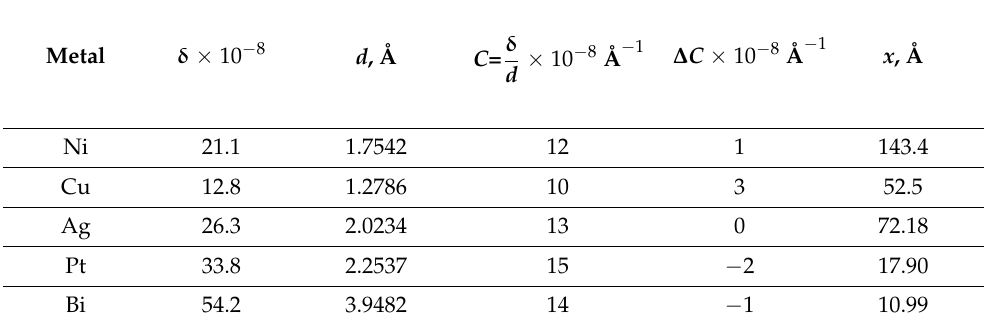
Table 2. Calculated values of δ , d , C , ∆ C and x